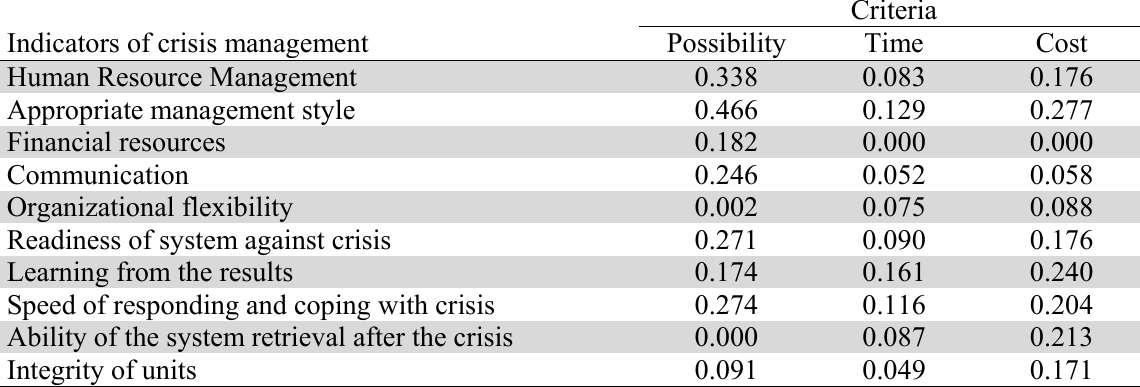
Distance of each of the options from positive and negative criteria